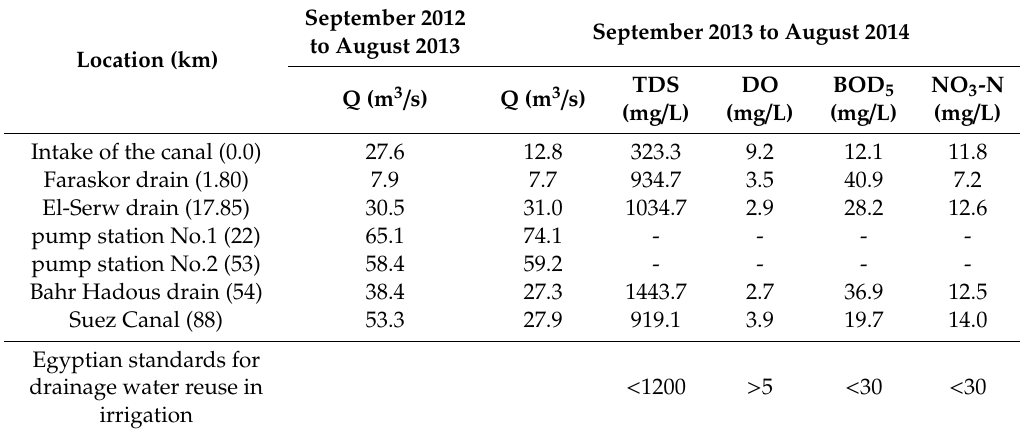
Table 1. The average discharges from September 2012 to August 2014 and WQ parameters from September 2013 to August 2014 for the locations along the El-Salam Canal.